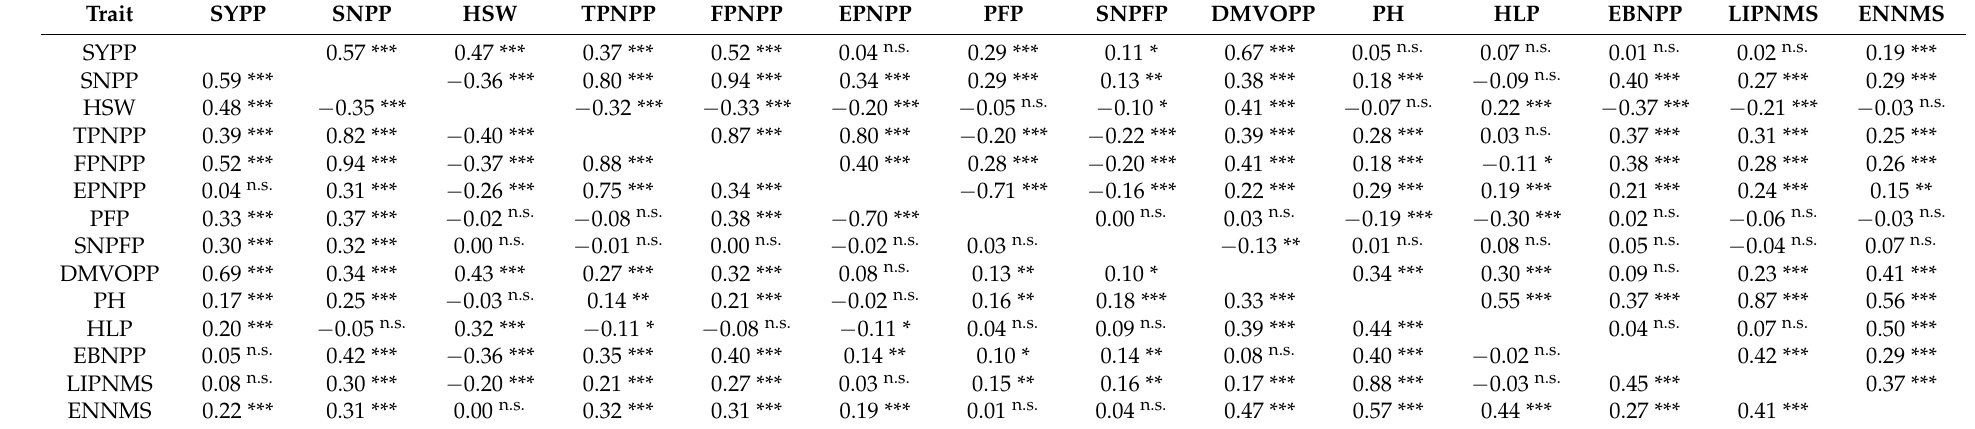
Table 3. Pearson correlation coefficients among traits potentially related to AR tolerance for the tested soybean population under the two simulated rain regimes.